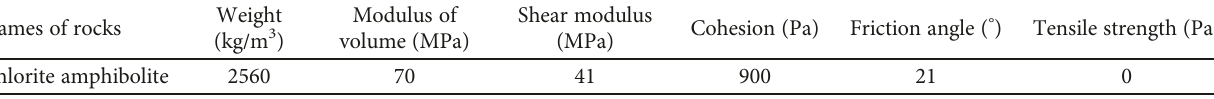
Figure 18: Sample SEM pictures before and after rainfall. Table 8: Model of physical and mechanical parameters.